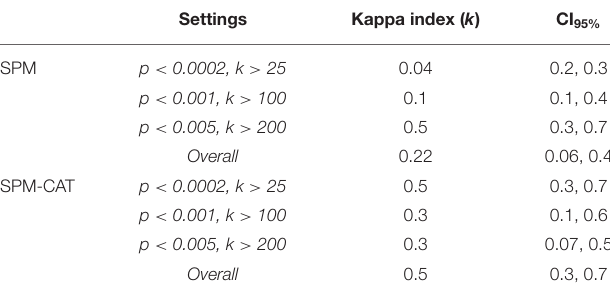
TABLE 5 | Concordance between the identified EZ by SPM and SPM-CAT and the postsurgical